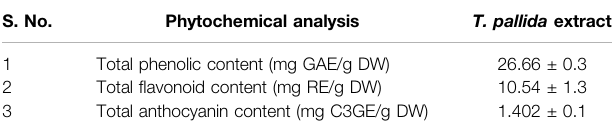
TABLE 1 | Total phenolic, fl avonoid, and anthocyanin contents of plant extract. S.